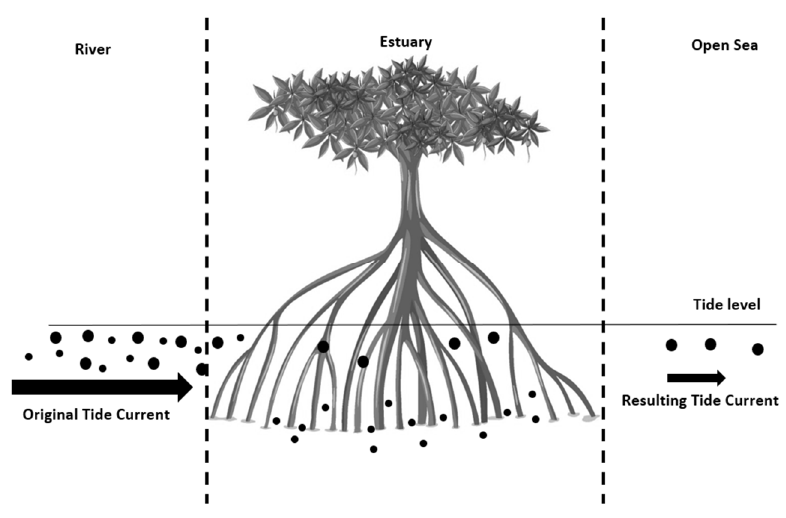
Figure 6. Mangrove forest specimens working as microplastic traps. Estuarine water tends to be a highly productive environment. Because of the eutrophic character of the water, a variety of fouling biota, such as algae or invertebrate species,